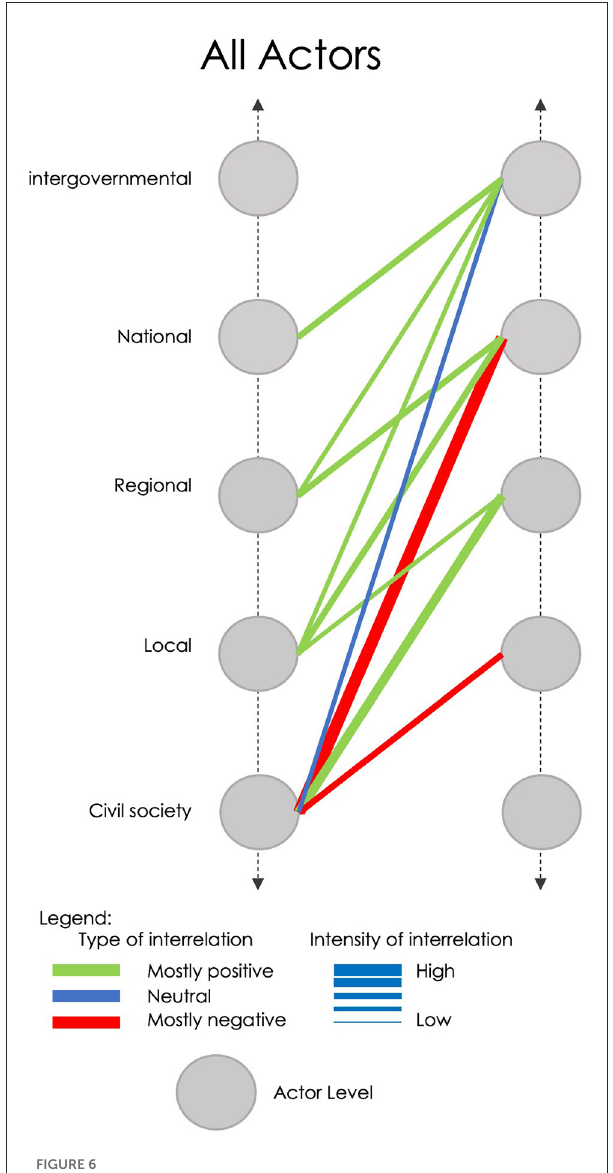
FIGURE6 Scheme of interrelation between territorial levels corresponding to all stakeholders. Source: Prepared by the